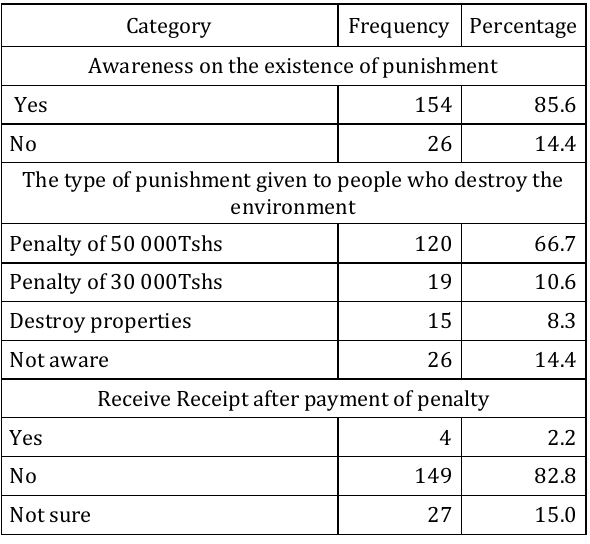
Table 3. Awareness, type of punishment and issuing